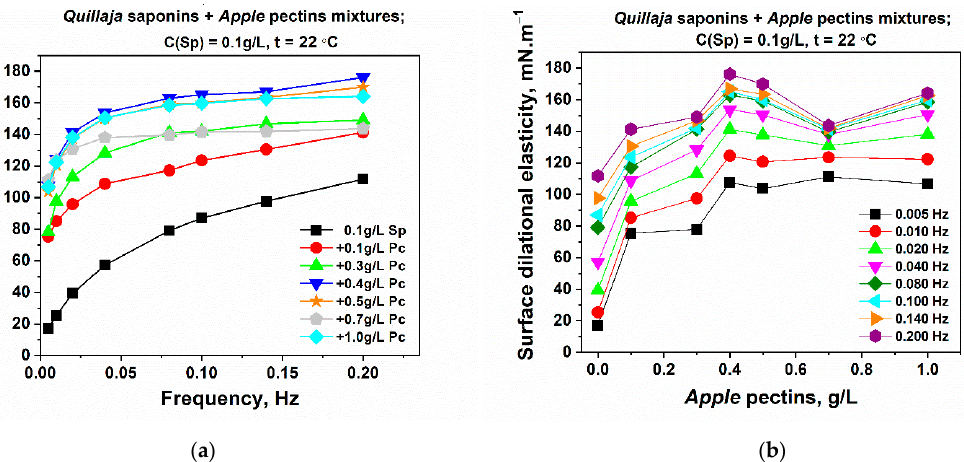
Figure 4. Surface dilational elasticity of adsorption layers of Quillaja saponin-only, and Quillaja saponin and Apple pectin mixtures at constant saponin concentration (C (Sp) = 0.1 g/L) ( a ) vs. frequency of the bubble’s deformations ( b ) vs. Apple pectin concentration.